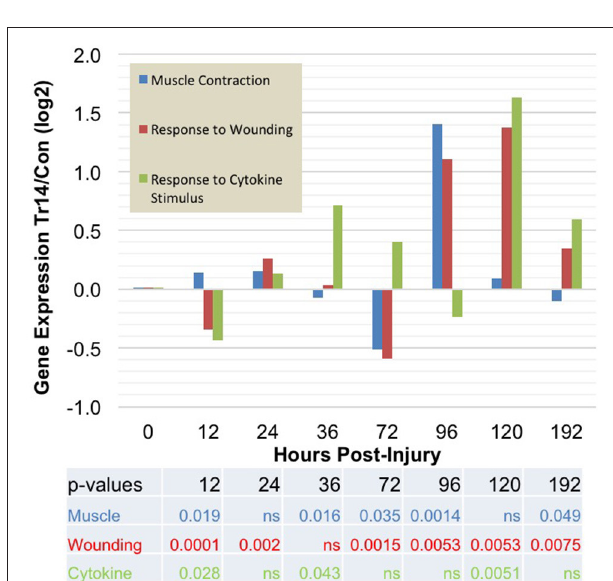
FIGURE 3 | The effect of Tr14 on gene expression patterns after wounding. The RNA sequencing results were analyzed to identify transcripts that were differentially expressed between placebo-treated controls and Tr14-treated wounds, at each time point after injury (X axis). The effect of Tr14 on a given ontology is shown as an aggregate gene expression score of the differentially expressed transcripts in that GO group, expressed as the log2 ratio of the Tr14 vs. control levels, (Y axis, log2 ratio Tr14/Con). For the Muscle Contraction GO, a total of 25 transcripts were affected covering 17 unique, non-redundant genes. Tr14 affected 87 transcripts (51 genes) in the Response to Wounding GO, and 9 transcripts (6 genes) in the Response to Cytokine Stimulus